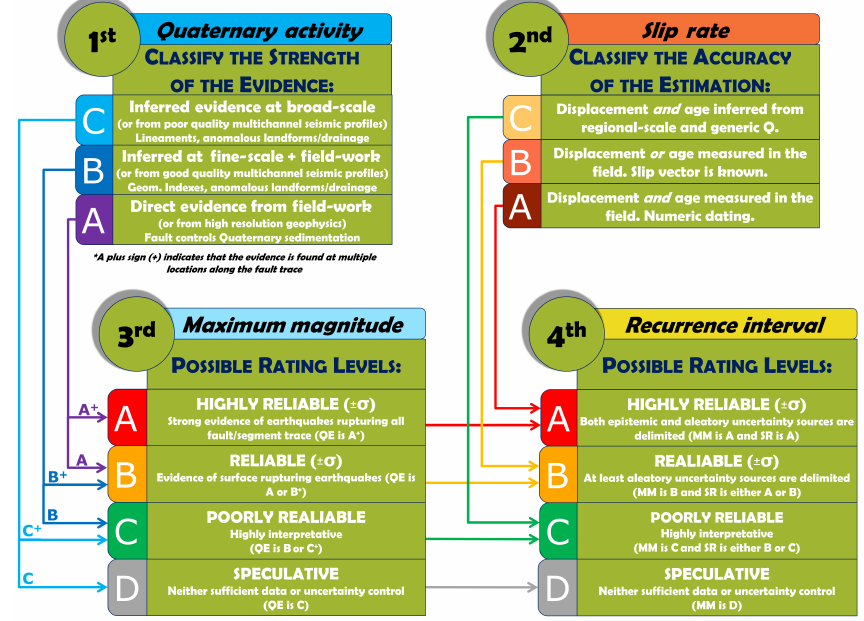
Figure 4. Diagram summarizing the scheme followed in QAFI v.3 for rating the reliability of maximum magnitude (RMM) and recurrence interval (RRI) on the basis of the strength of the Quaternary activity evidence (SQE) and the accuracy of the slip rate estimation (ASR). First, the SQE of the fault is classified based on the detail of the available published observations in three increasing levels of accumulated evidence, varying from C (weak) to A (very strong). A plus sign ( + ) is assigned when the observations can be extrapolated with confidence all along the fault trace. Second, the ASR is classified based on the accuracy of the information used for its determination, varying from C (rough) to A (accurate). Third, RMM is obtained from SQE class, varying from A (highly reliable) to D (speculative). Fourth, RRI is obtained from both RMM and ASR. The resulting RRI would never be higher than the rated level for RMM, yet it could be lower depending on the ASR (these relationships are not shown on the diagram for the sake of simplicity). See text and Table 1 for a more extensive